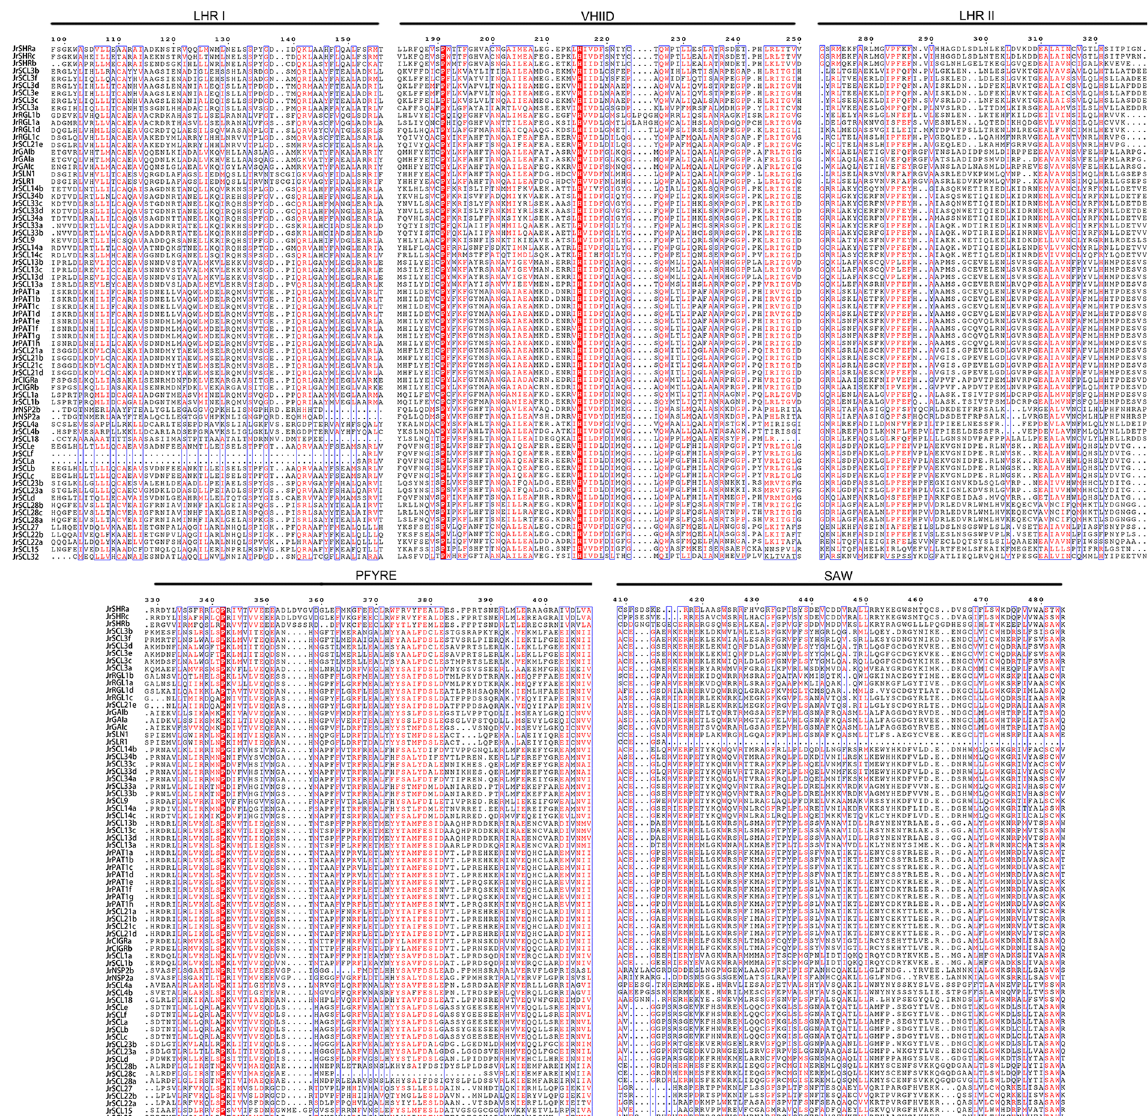
Figure 2. Alignment of the walnut GRAS protein sequences. The highly conserved regions of the Jr GRAS proteins were divided into five recognizable